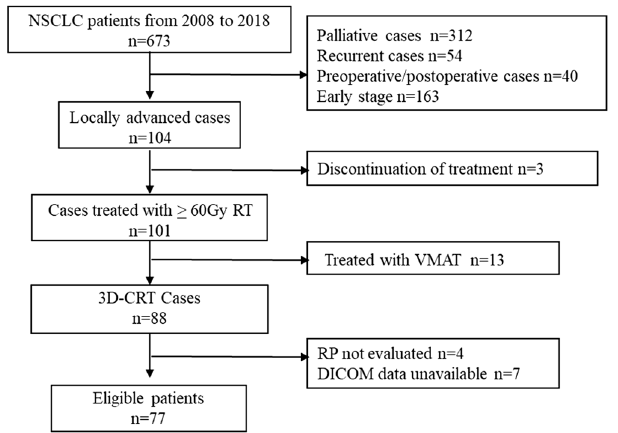
Figure 2. Enrollment characteristics of the study participants. NSCLC non-small cell lung cancer, RT radiotherapy, 3D-CRT three-dimensional conformal radiotherapy, VMAT volumetric-modulated arc therapy, RP radiation pneumonitis, DICOM Digital imaging and communications in